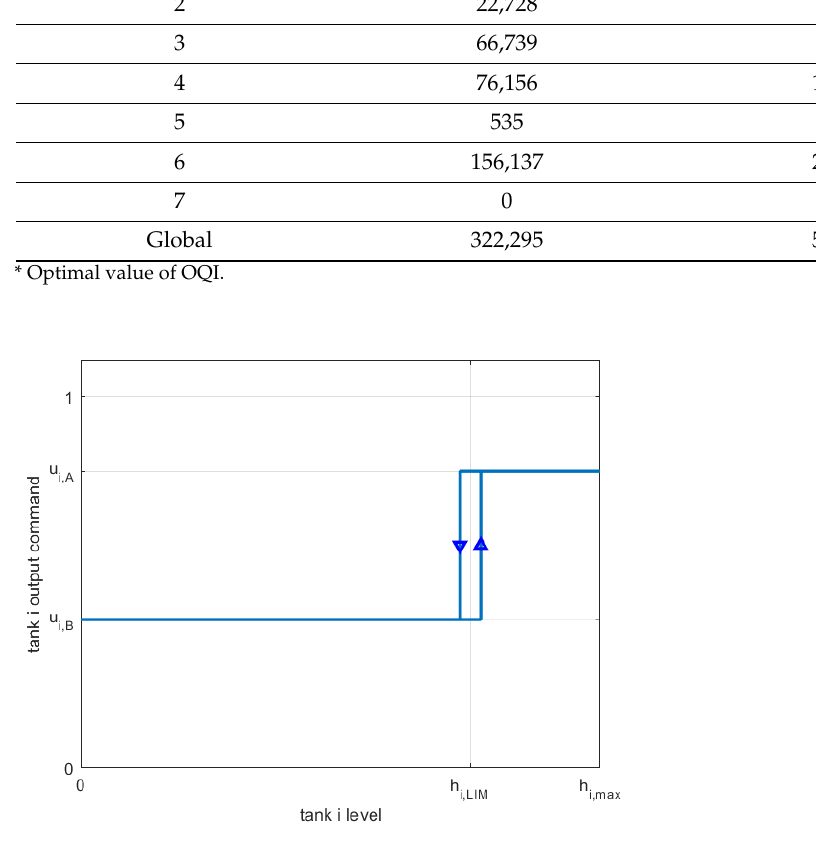
Table 10. Simulation results when the overflow quality index is minimized (strategy #2).